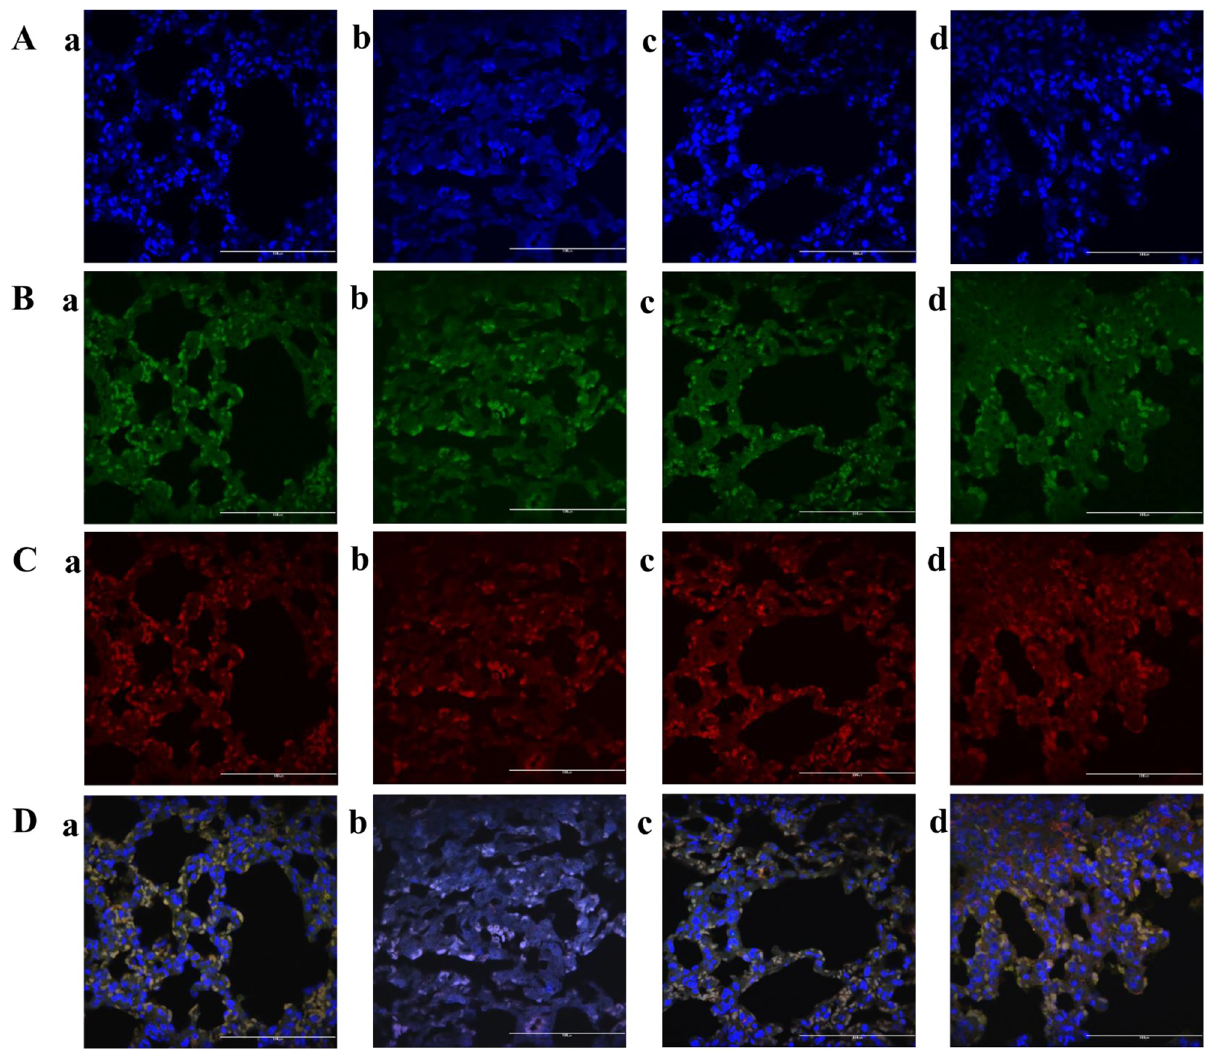
Fig 5. Macmoondongtang effectively induced the inactivation of both Th1 and Th2 cell transcription factors. (A) Nuclei are shown in blue color by DAPI staining. (B) Images displaying results of T-bet staining by FITC. (C) GATA-3 staining by AlexaFluor 1 555. (D) Merged images of nuclei stained with DAPI, T-bet stained with FITC, and GATA-3 stained with Alexa Fluor 1 555. Treatment with dexamethasone and macmoondongtang completely abrogated the activation of both Th1 cell transcription factor T-bet and Th2 cell transcription factor GATA-3. a , vehicle control; b , asthma induction; c , dexamethasone; d ,1500 mg/kg/day macmoondongtang. Scale Bar = 100 μ m. Magnification, × 1000.